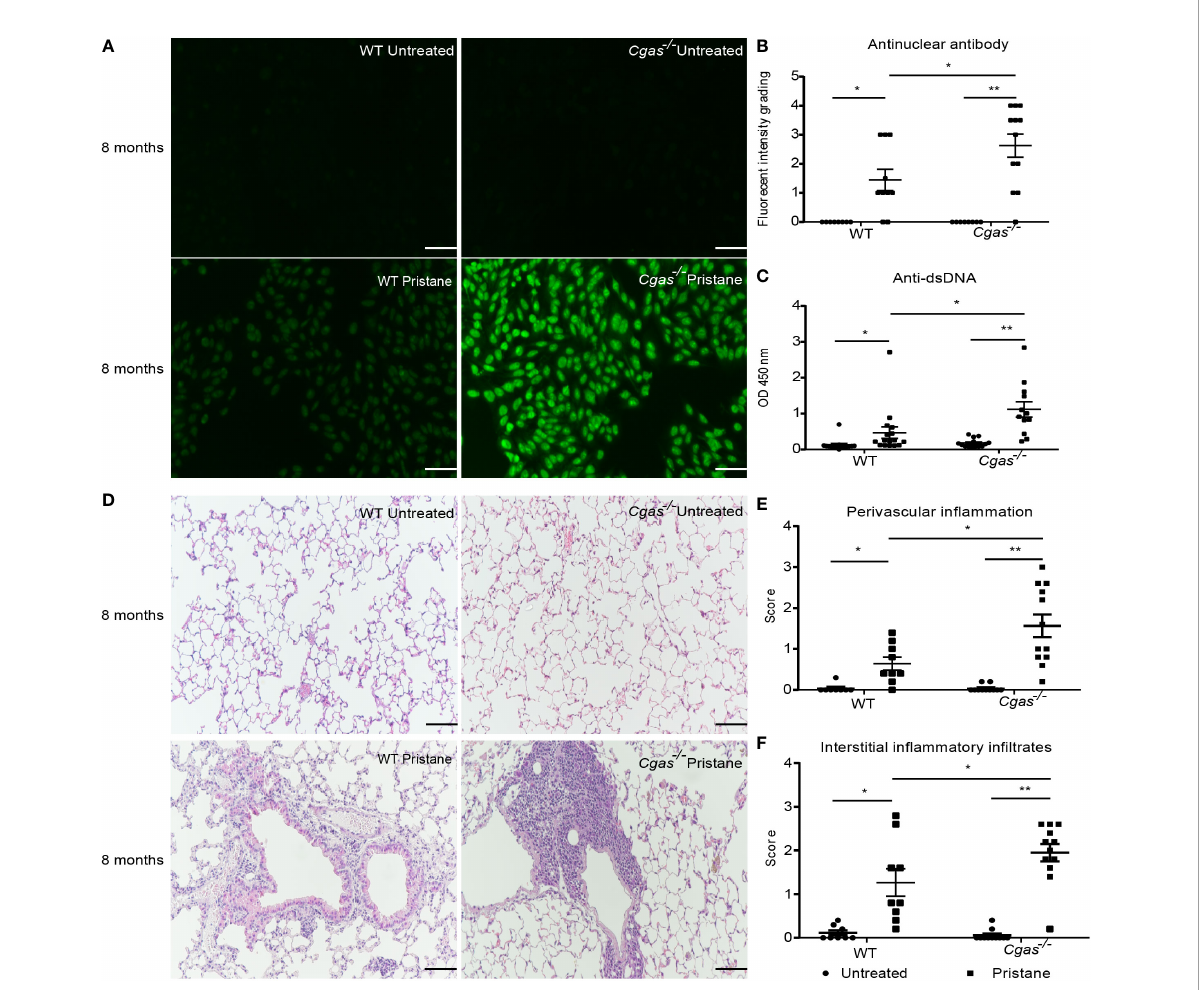
FIGURE 1 Loss of the cGAS sensor promotes autoantibody production and the pulmonary in fl ammatory response in the pristane-induced lupus model. The mice were sacri fi ced at 8 months to collect the tissues and sera after pristane injection. (A) The anti-nuclear antibodies (ANA) from sera were detected using HEp2 substrate slides at a 1:2000 dilution (n = 8-12 per group). Representative pictures from each group are shown at 200X magni fi cation (scale bar, 100 µm). (B) The slides were graded by fl uorescence intensity. (C) Serum levels of anti-dsDNA were detected by ELISA (n = 12-16 per group). (D) Lung tissues were stained with H&E. Representative pictures from each group are shown at 200X magni fi cation (scale bar, 100 µm). (E, F) Perivascular in fl ammation and interstitial in fl ammatory in fi ltrate scores of lung sections were blindly graded (n = 8-12 per group). Data are shown as the mean ± SEM of 3-5 independent experiments (A – F). *p < 0.05, **p <